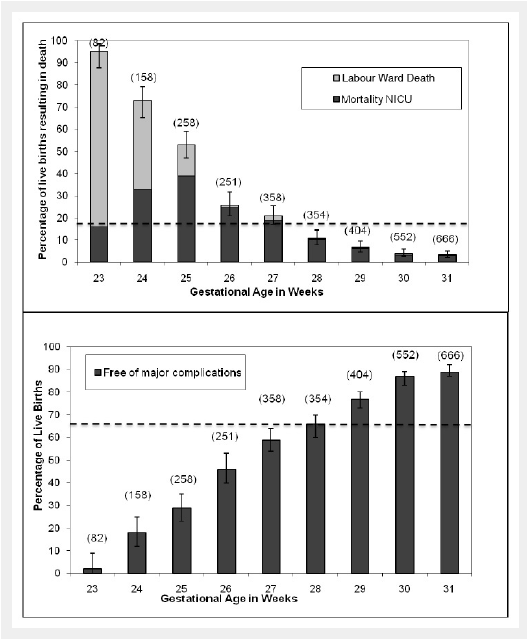
Gestational age stratified mortality rates and rates of free of major complications. CI for mortality is indicated by the error bar. Absolute number of total births by stratum is indicated by the N in (). Overall rate is indicated with the dashed line, 19% mortality rate and 66% free of major complications.